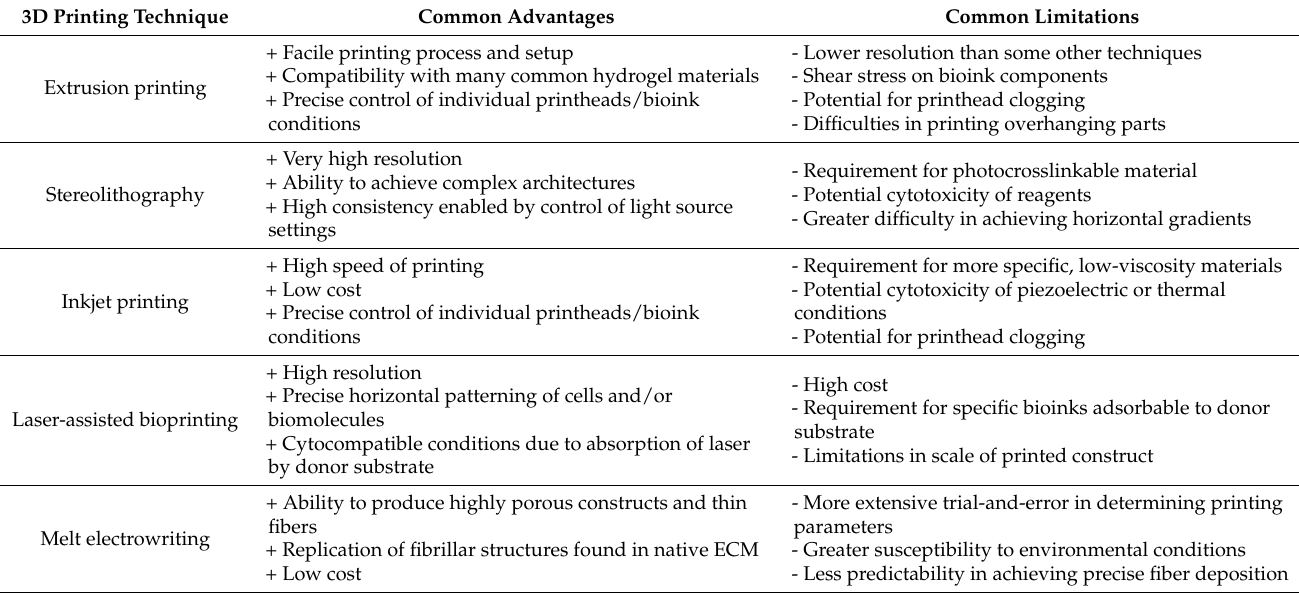
Table 1. Common 3D printing techniques utilized for hydrogel